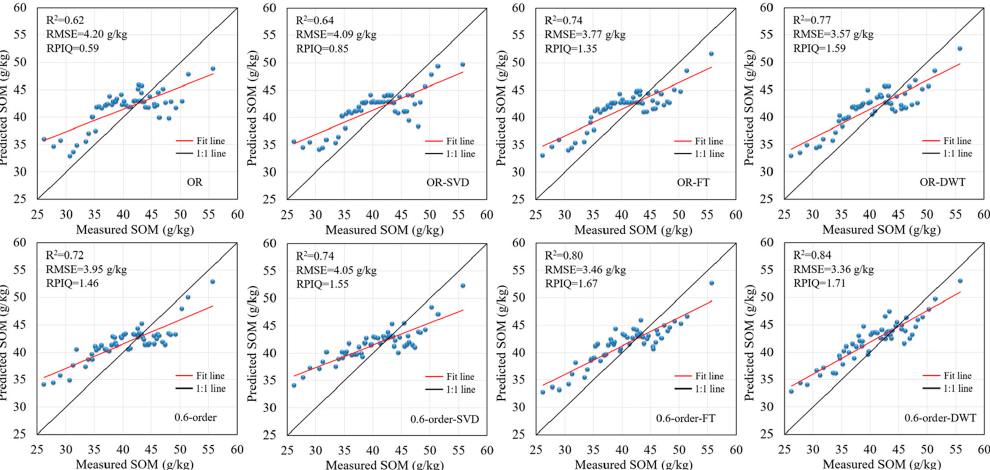
Figure 5. Scatter plots of the laboratory-measured versus predicted SOM contents from the validaTable 1. line, and the red solid lines represent the regression line.